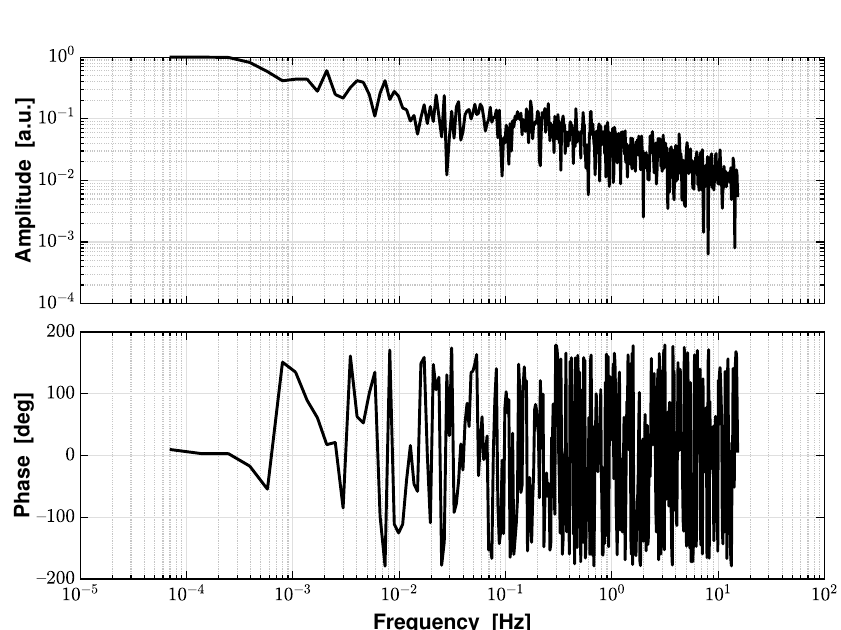
Figure 10. The amplitude and phase of the coherence function between the displacement and the temperature measurements. In the low frequency regime below 1 mHz, it shows a strong correlation between the displacement and the temperature measurement as the amplitude is large than 0.5, and a time delay effect as the phase is